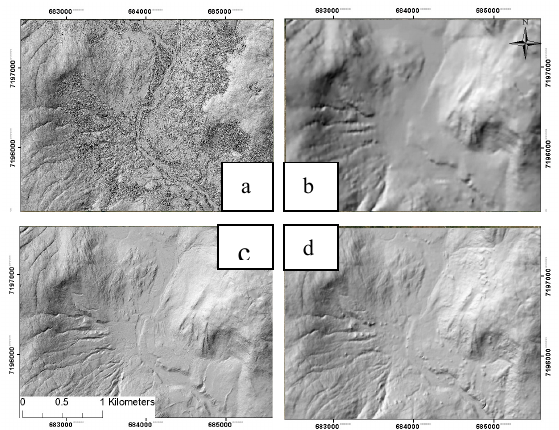
Figure 3. The DSM of the test site 2 ( a ) together with the view shed of the DTED10 ( b ), the ALSDTM ( c ) and the newly computed DTM ( d ) of the same area